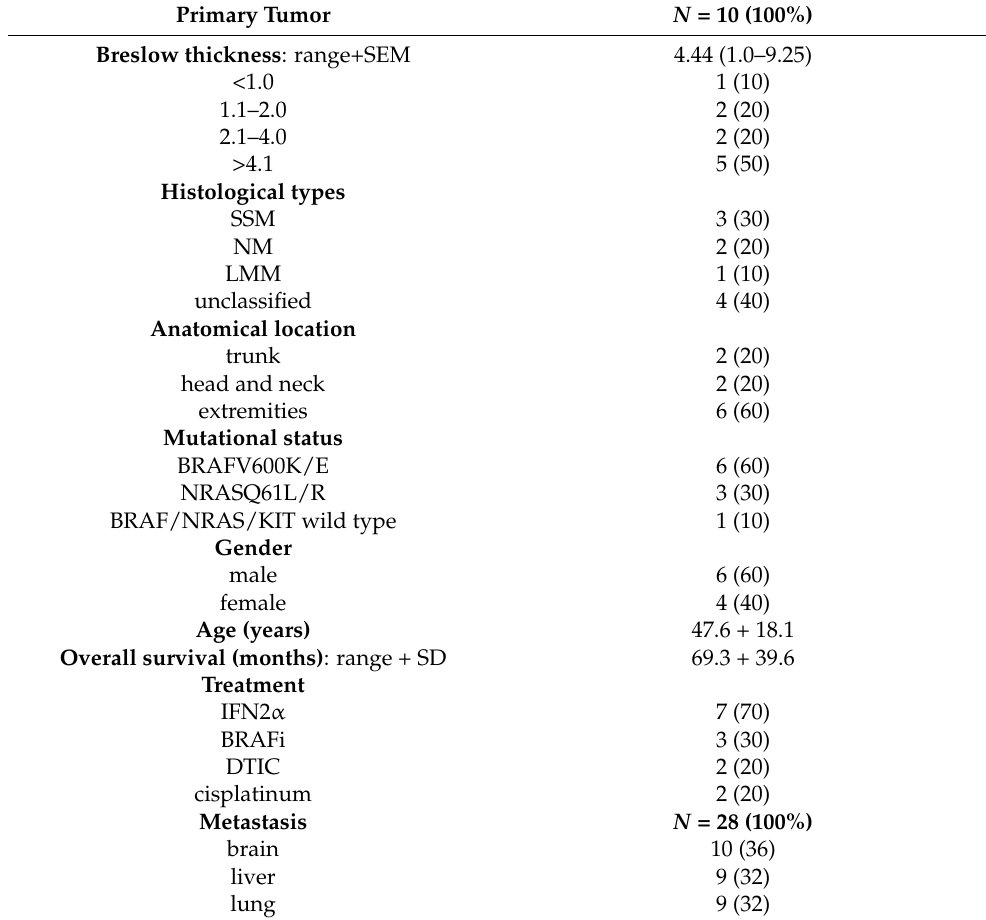
Table 1. Metastatic melanoma patient